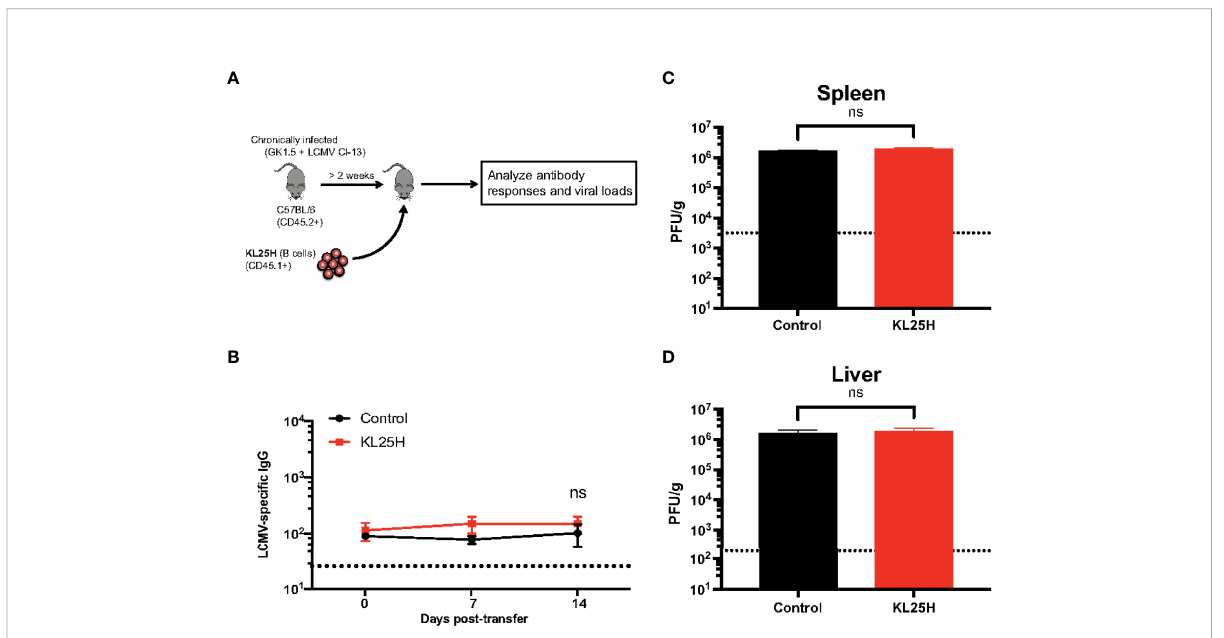
FIGURE 4 Antigen speci fi city is required for adoptive B cell therapy to be effective. (A) Experimental outline for evaluating the effect of B cell transfer during a chronic viral infection. Mice chronically infected with LCMV Cl-13 received 5x10 6 KL25H B cells. (B) Summary of virus-speci fi c antibody levels in sera. (C) Summary of viral loads in spleen. (D) Summary of viral loads in liver. The limit of detection is indicated by a dashed line. Experiments were performed 2 times, n=3-4 mice per experiment. Error bars represent SEM. The p-values were calculated using Mann-Whitney test. ns, not signi fi cant. Dotted line represents limit of